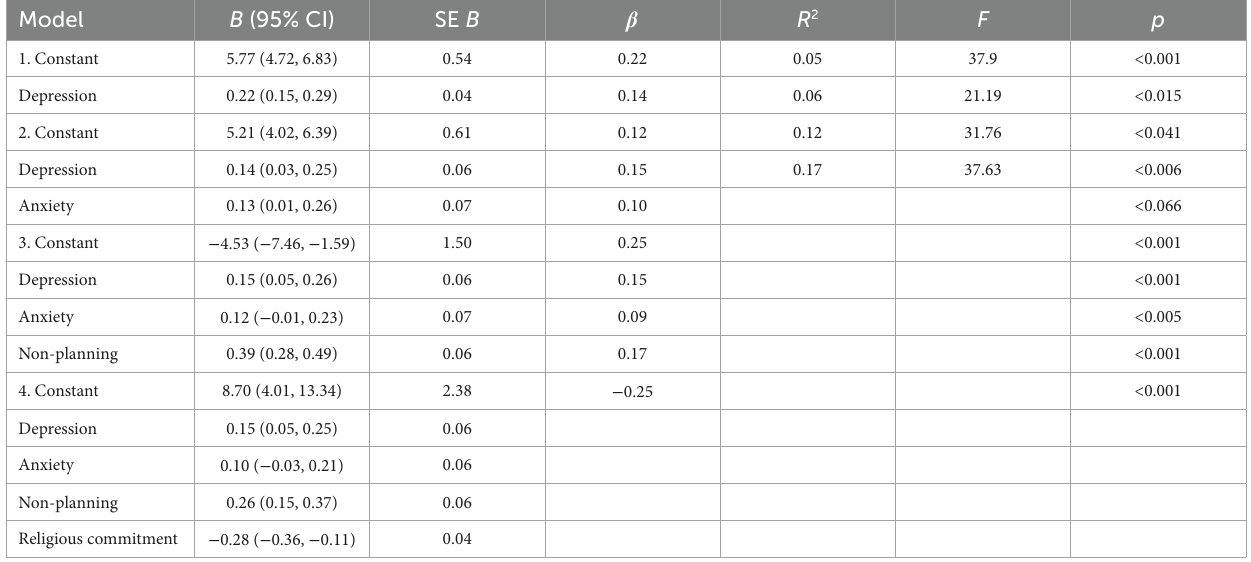
TABLE 3 Regression analyses.